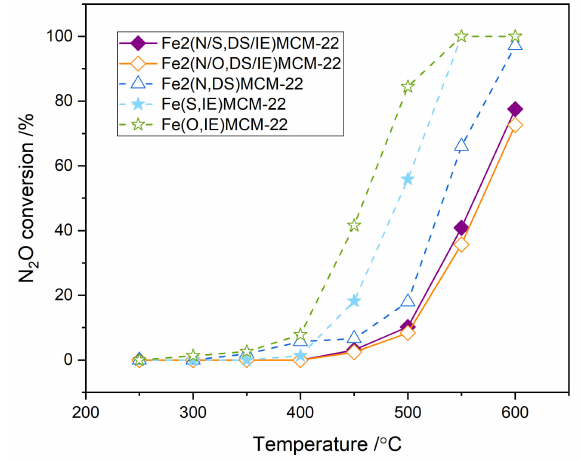
Figure 9. Temperature dependence of N 2 O conversion over the samples doubly modified with iron, compared with the Fe2(N,DS)MCM-22, Fe(S,IE)MCM-22, and Fe(O,IE)MCM-22